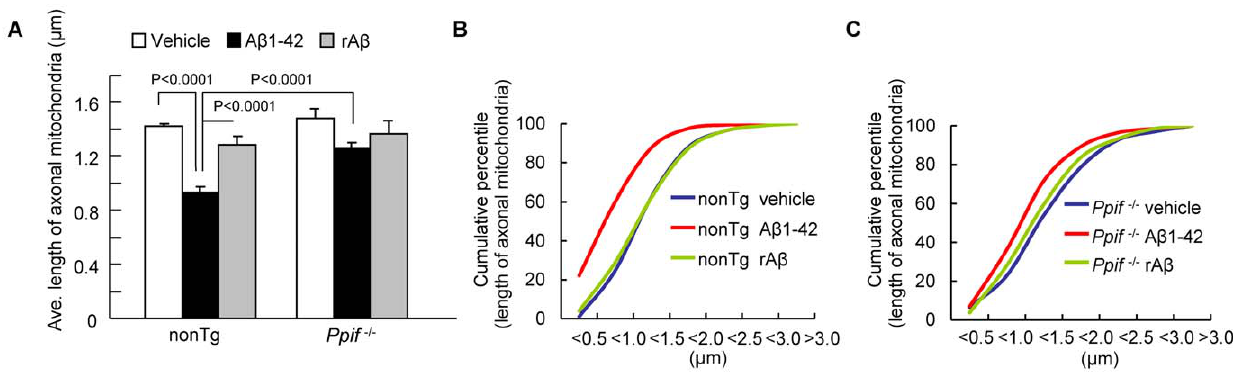
Figure 2. Effect of CypD on A b -induced changes in axonal mitochondrial morphology. ( A ) The average length of axonal mitochondria decreased in A b -treated nonTg neurons, but was largely preserved in Ppif 2 / 2 neurons. Data were collected from 3 independent experiments. ( B, C ) Cumulative distribution data showed that A b treatment caused a remarkable increase in fragmentation of small mitochondria and a decrease in the numbers of long mitochondria in nonTg neurons; this was partially attenuated in Ppif 2 / 2